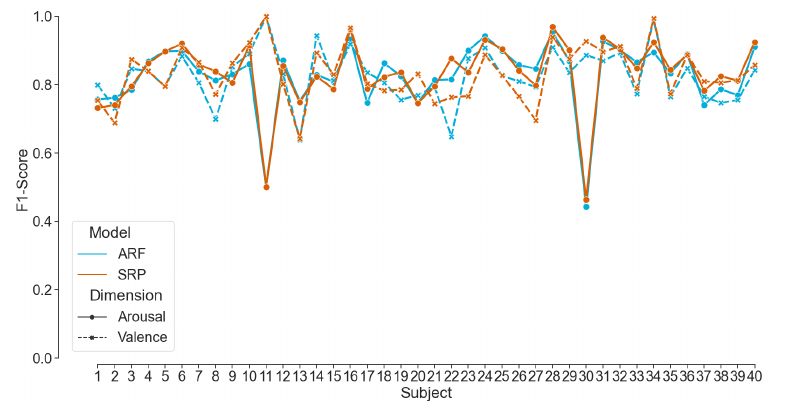
Figure 9. F1-Score for Valence and Arousal classification achieved by ARF and SRP per subject from Dataset